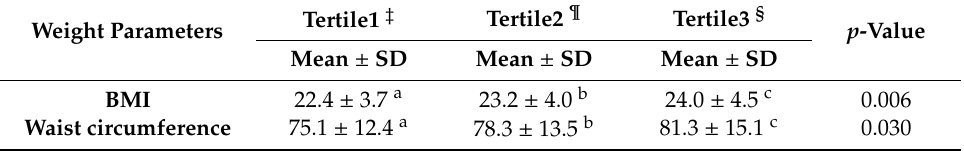
Table 4. Association between calorie consumption from SSBs and body weight parameters †